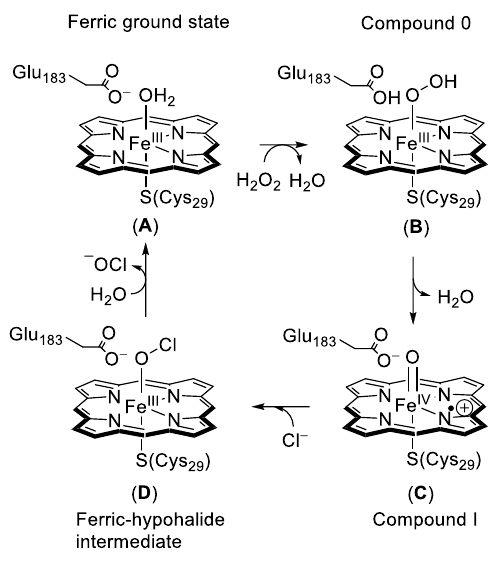
Figure 4. Catalytic cycle of the heme haloperoxidase from chloroperoxidases (CPO). For clarity, the side chains of the heme have been